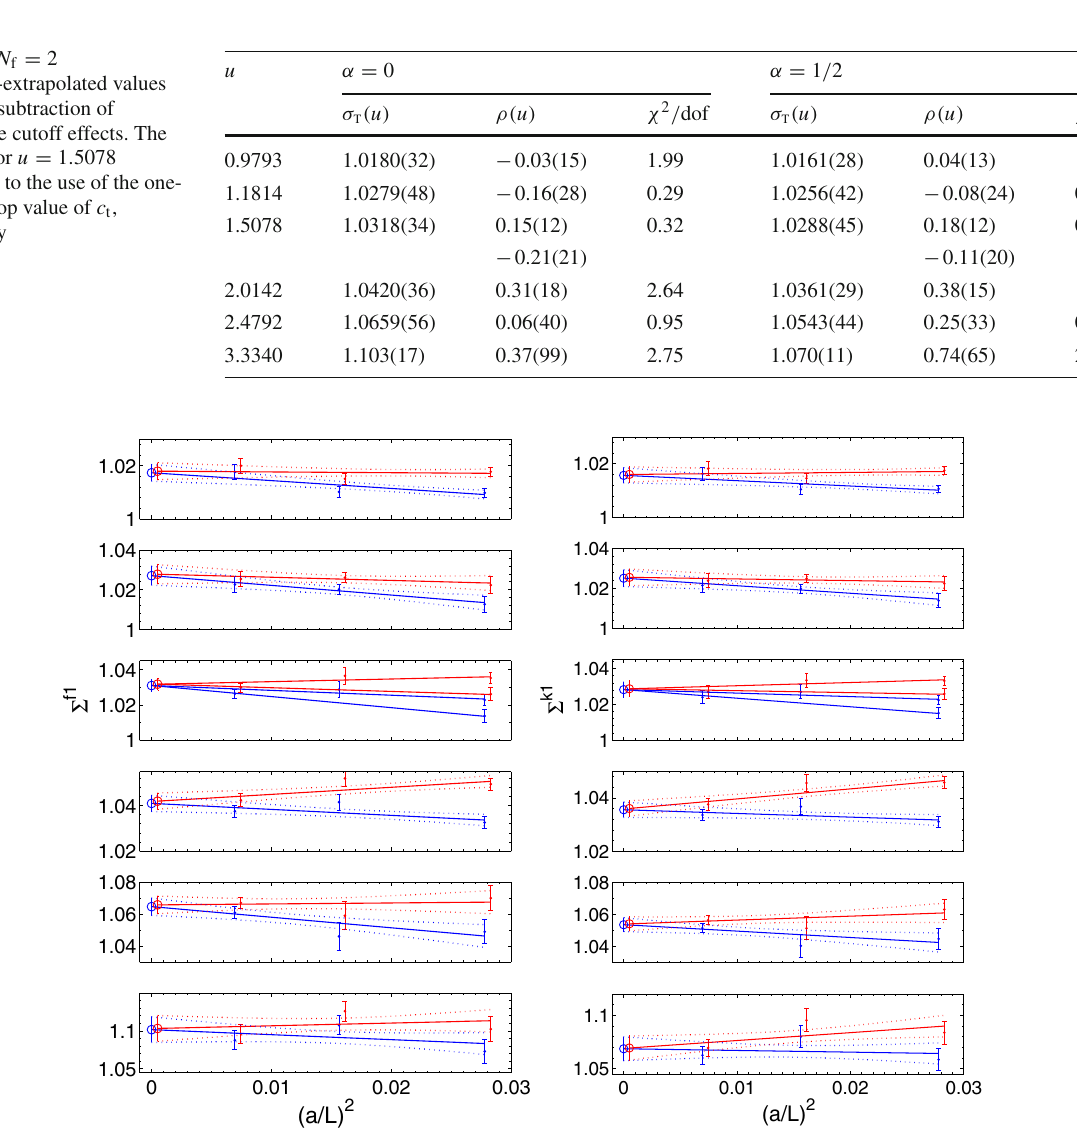
Fig. 7 Continuum extrapolations of SSFs for N f = 2 in the schemes α = 0 (left) and α = 1 / 2 (right). Blue points are the data in Table 13; red points result from subtracting the one-loop value of cutoff